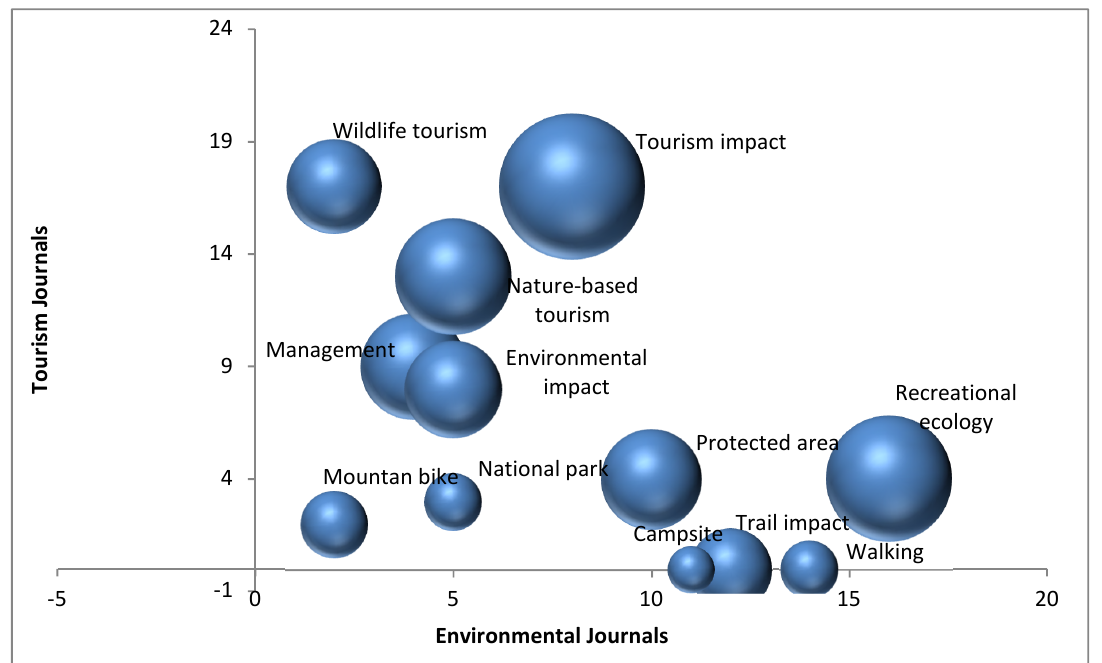
Figure 2. Keyword analysis of recreational ecology papers (JOST, TM, JEM, EM, 1976–2017).